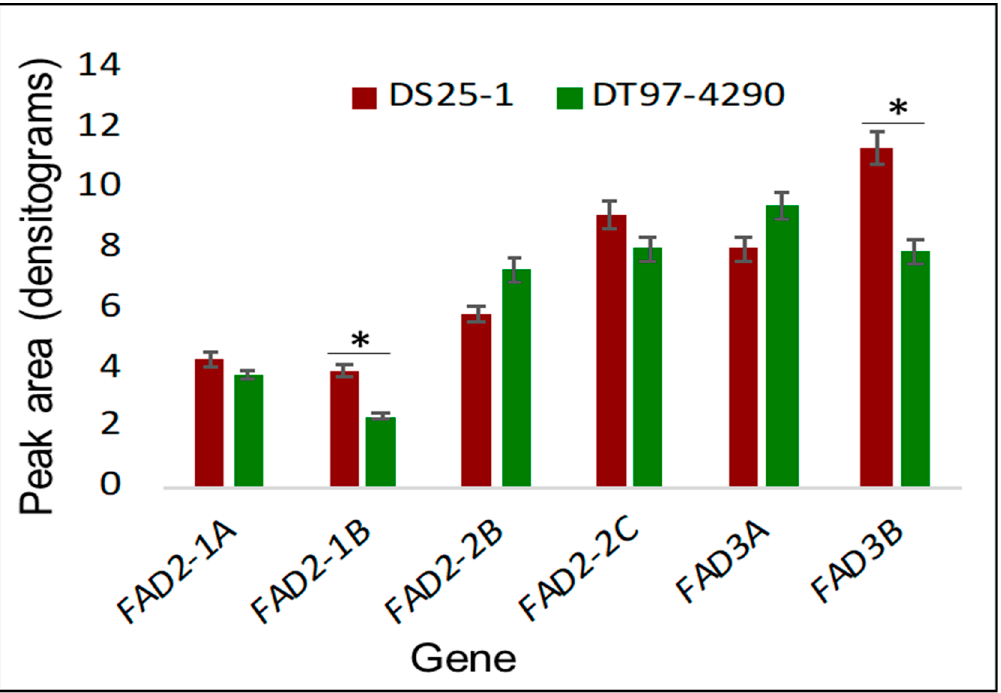
Figure 4. Expression analysis of the Fatty Acid Desaturase ( FAD ) genes under optimal temperature conditions in the leaf samples (26 days old) of a heat-tolerant soybean genotype DS25-1 and heat-susceptible soybean genotype DT97-4290. The two soybean genotypes did not show any significant di ff erences in the expression pattern of the FAD2-1A , FAD2-2B , FAD2-2C , and FAD3A genes under optimal temperature conditions (30 / 20 ◦ C). The asterisk signifies a significant di ff erence in the expression level of the FAD genes in the two soybean genotypes. Semi-quantitative reverse transcription-polymerase chain reactions (RT-PCRs) were performed using gene-specific primers [24], except for the FAD3A and FAD3B genes. The FAD3A and FAD3B genes were amplified together using a primer pair, and the two transcripts were discriminated via restriction digestion of the amplified fragment with the Van91 I enzyme [25,27] (see Table S1 for primer details and PCR conditions). Following PCR, products were loaded onto agarose gel and the gel images were used for densitometric analysis. In all cases, gene expression results were normalized to the expression of the housekeeping gene. The Student’s t -test was used to compare the expression levels of the FAD genes in DS25-1 and DT97-4290. The error bars signify the standard error.